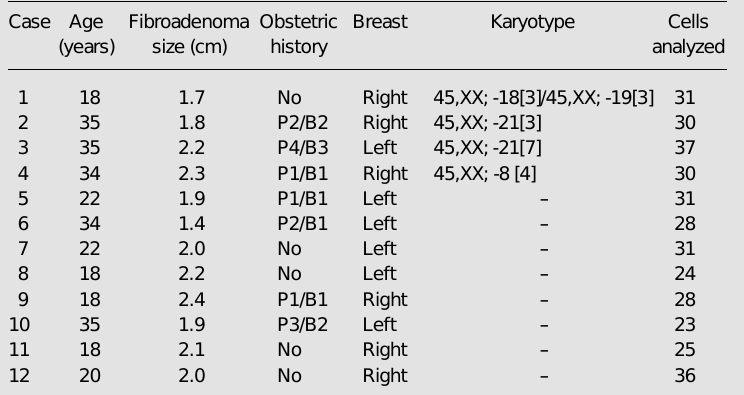
Table 1. Clinical data and abnormal clonal karyotypes. Case